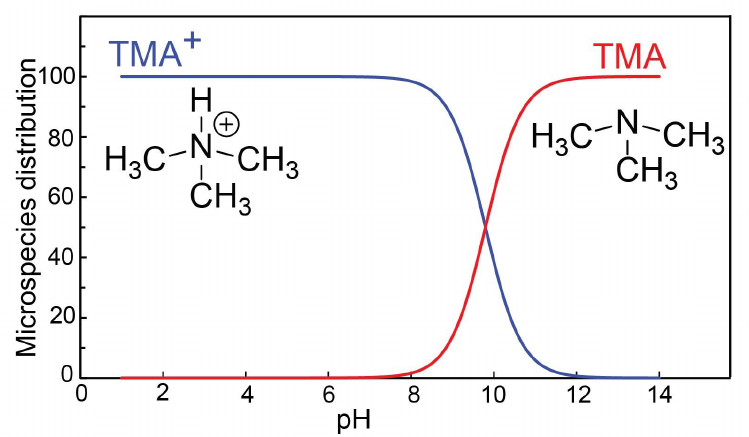
Figure 2. Distribution of TMA and TMA + at different pH values. Distribution is calculated using a pKa value of 9.8 for